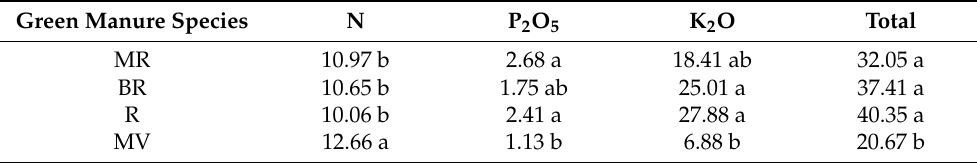
Table 1. Differences in nutrient accumulation of green manure species (kg hm − 2